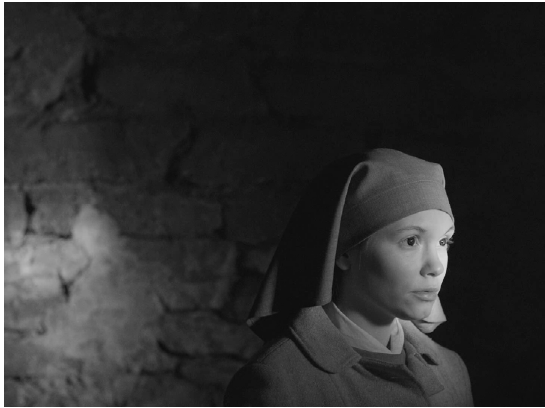
Figure 2 . Ida at her mother’s window. Figure 3. The light of the window on Ida. Figure 3. The light of the window on